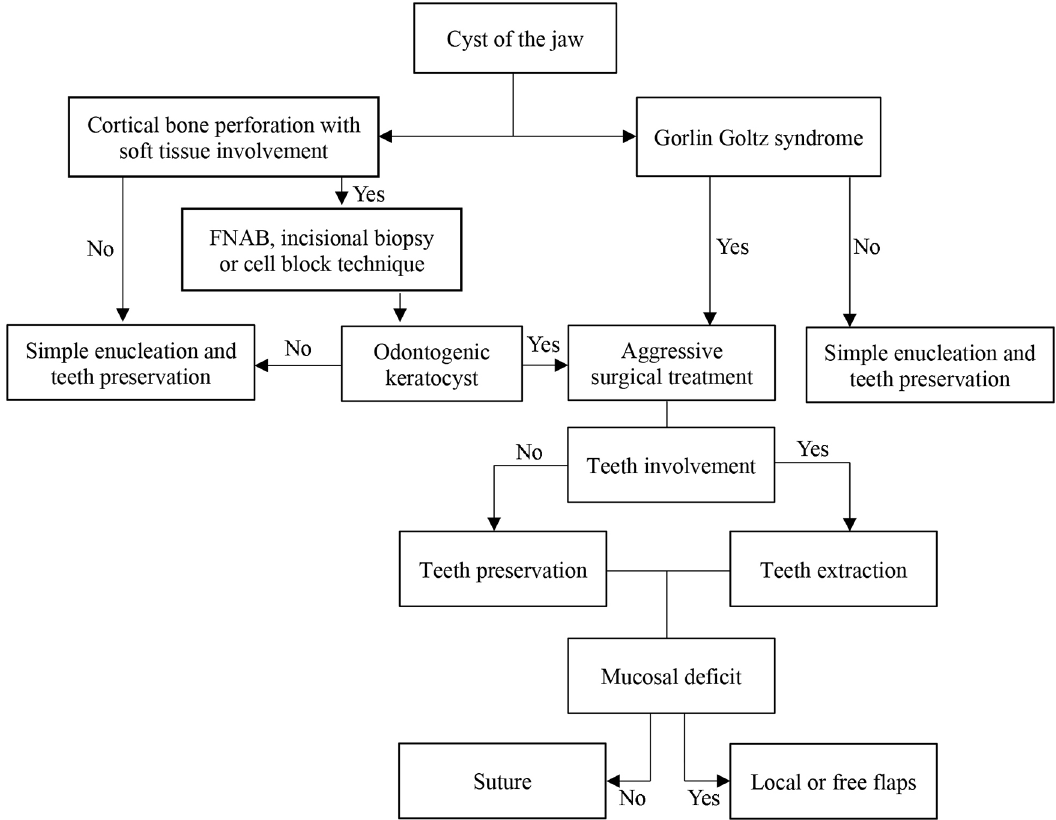
Fig. 6. Flow-chart for the treatment depending on risk factor of